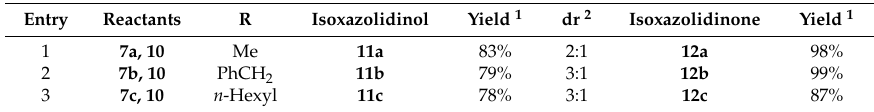
Table 2. Pyrrolidine-catalyzed synthesis of isoxazolidin-5-ols 11a – 11c from α -substituted enals 7a – 7c and N -Cbz-hydroxylamine 10 , and oxidation to the corresponding isoxazolidin-5-ones 12a – 12c . Entry Reactants